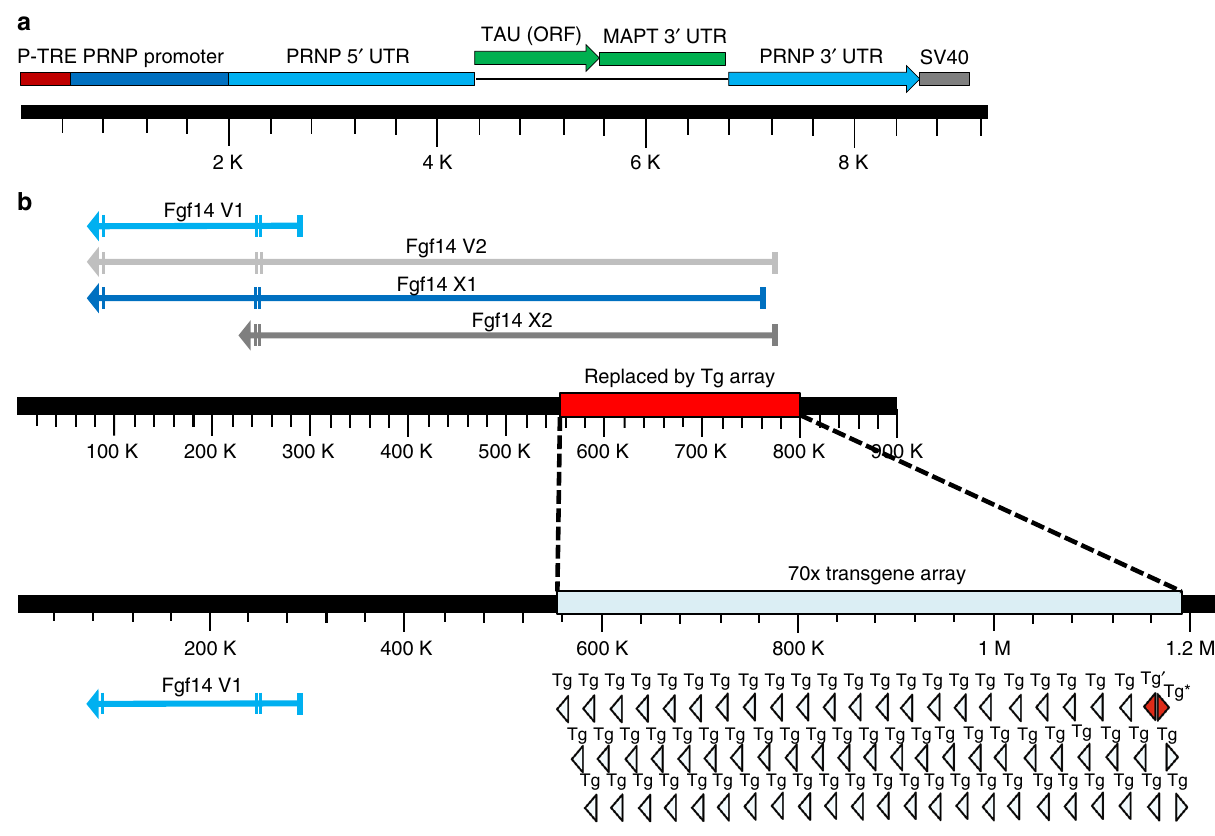
Fig. 3 Fgf14 is disrupted by a tau transgene array in Tg4510 mice. a Structure of the tau transgene monomer including the tetracycline response element (TRE) promoter, prion protein gene ( Prnp ) sequences, tau cDNA open reading frame (ORF), Mapt 3 ′ untranslated region (UTR), and SV40 polyadenylation signal. b Diagram of Fgf14 mRNA splice variants and disruption by the transgene array. Vertical hashmarks in splice variants represent exons while arrows indicated the direction of synthesis. The red rectangle on the non-transgenic allele (top) represents the 243,608bp deletion while the light blue rectangle on the transgenic allele (bottom) represents the approximately 70-copy insertion of the Tg multimer array. Tg, transgenes are light blue triangles, Tg ′ , partial transgene copy red triangle in the 3 ′ → 5 ′ orientation, Tg*, partial transgene copy red triangle in the 5 ′ → 3 ′